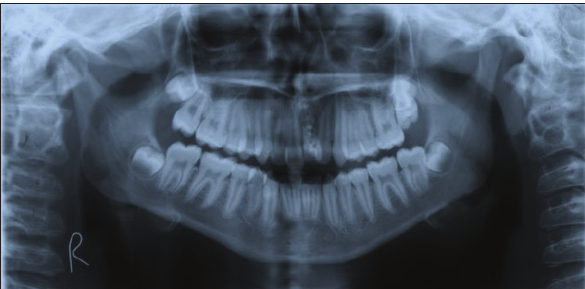
Figure 2a. Pre-treatment dental panoramic radiograph.